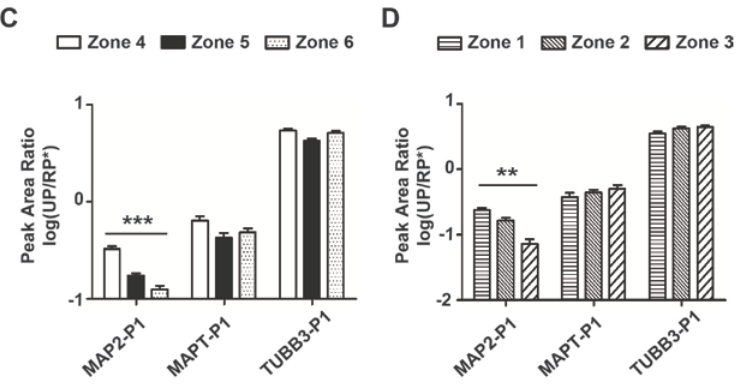
Figure 4. Distribution of neurofilament and microtubule peptides/proteins in both intact and infarcted brain tissues. ( A ) Proteins in zones 4–6 of intact brain tissue were collected by LCM, 10 mm 2 for each area, and then analyzed by a triple-quadrupole mass spectrometer. Four neurofilament proteins were verified and semi-quantified by LCM–LRP. Each protein was verified by 2–3 unique peptides and quantified by the peak area. The unique peptides with the greatest peak area are shown. Peak area ratios of unique peptides to RP* were calculated (UP/RP*) ( n = 12); ( B ) Four neurofilament proteins in zones 1–3 of infarcted brain tissue were collected by LCM, and then the peak area ratios of 4 unique peptides to RP* were determined ( n = 12); ( C ) There were 3 microtubule proteins from zones 4–6 of intact brain tissues verified and semi-quantified by LCM–LRP. Each protein was verified by 2–3 unique peptides and quantified by the peak area. The unique peptides with the greatest peak area are shown. Peak area ratios of unique peptides to RP* were calculated (UP/RP*) ( n = 12); ( D ) Three microtubule proteins in zones 1–3 of infarcted brain tissue are collected by LCM, and then the peak area ratios of 3 unique peptides to RP* were determined ( n = 12). Unique peptide 1 for neurofilament light polypeptide (NEFL-P1), FTVLTESAAK; unique peptide 1 for neurofilament heavy polypeptide (NEFH-P1), FAQEAEAAR; unique peptide 1 for α-internexin (INA-P1), AQLEEASSAR; unique peptide 1 for glial fibrillary acidic protein (GFAP-P1), ALAAELNQLR; unique peptide 1 for microtubule-associated protein 2 (MAP2-P1), GLSSVPEVAEVETTTK; unique peptide 1 for microtubule-associated protein tau (MAPT-P1), TPSLPTPPTR; unique peptide 1 for tubulin beta-3 chain (TUBB3-P1), YLTVATVFR. * p < 0.05; ** p <